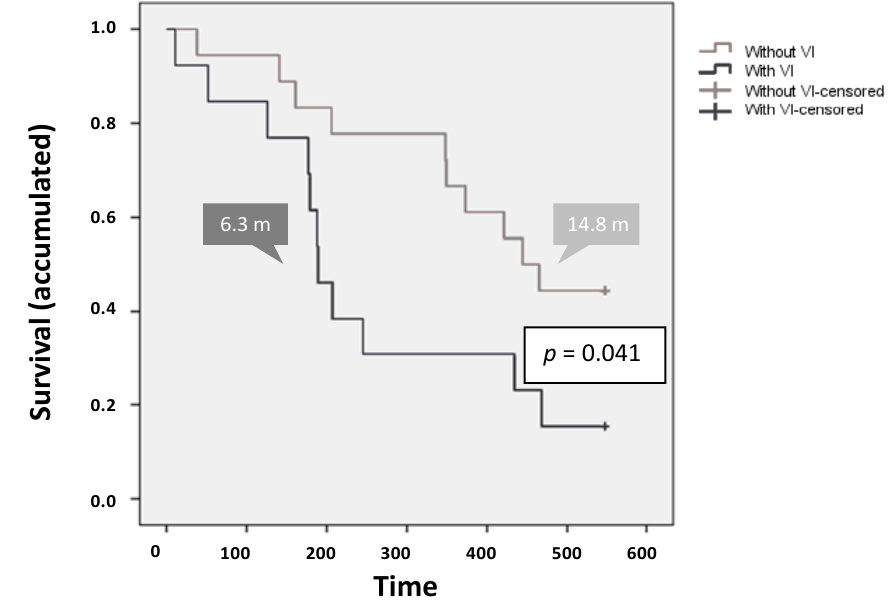
Figure 4. Survival by presence/absence of vascular invasion.